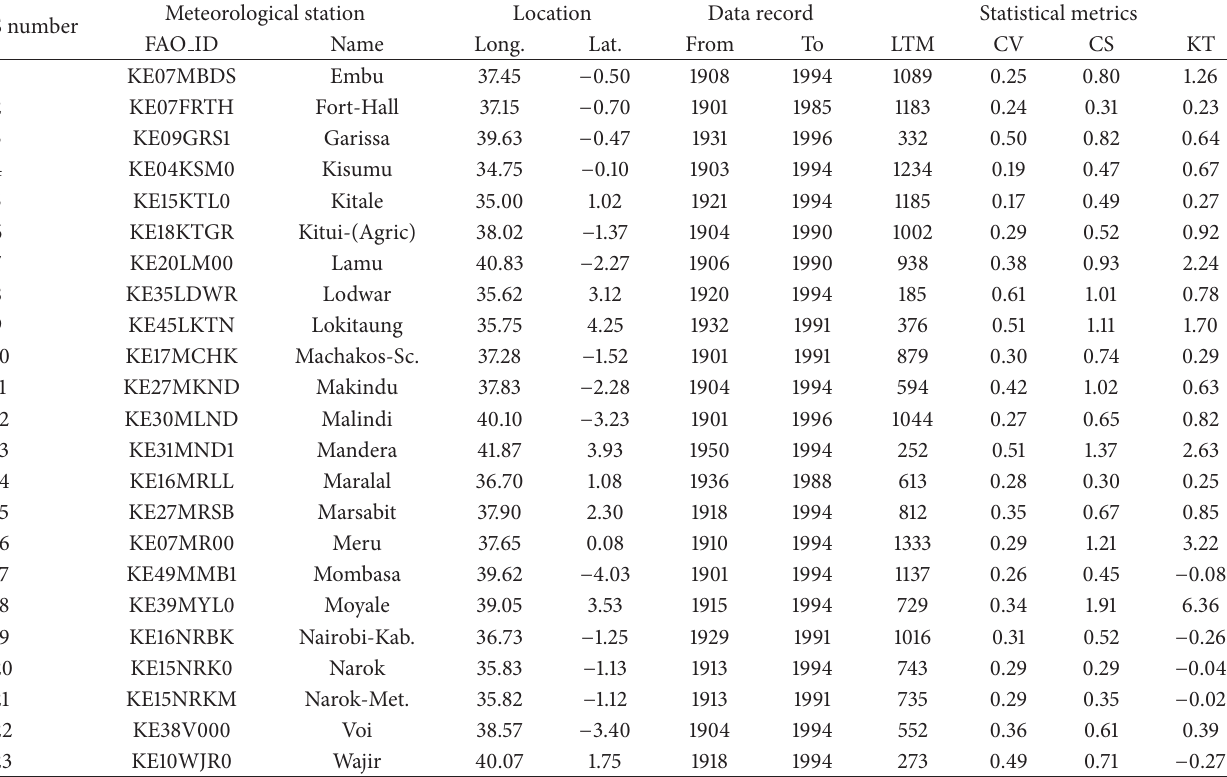
Table 1: Details of meteorological stations and rainfall series used in the case